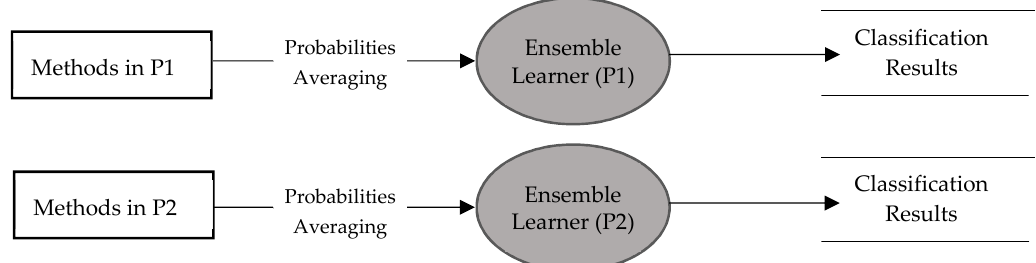
Figure 8. Diagram showing ensemble of methods in P1 and P2.